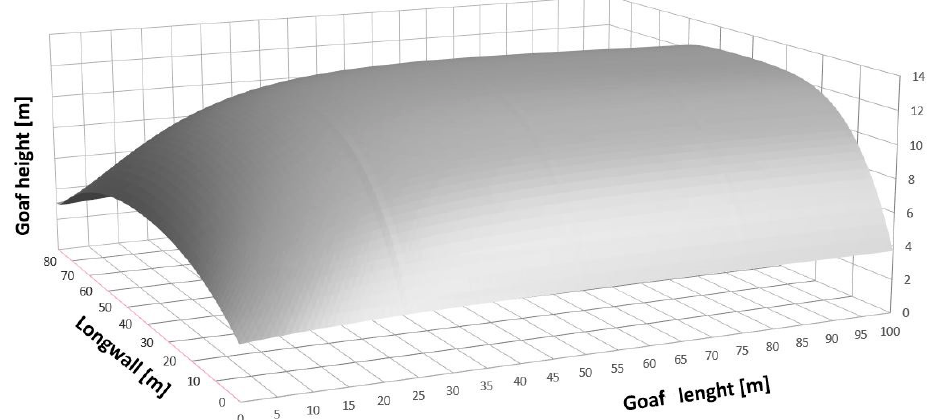
Figure 3. Goaf height distribution—perspective view.